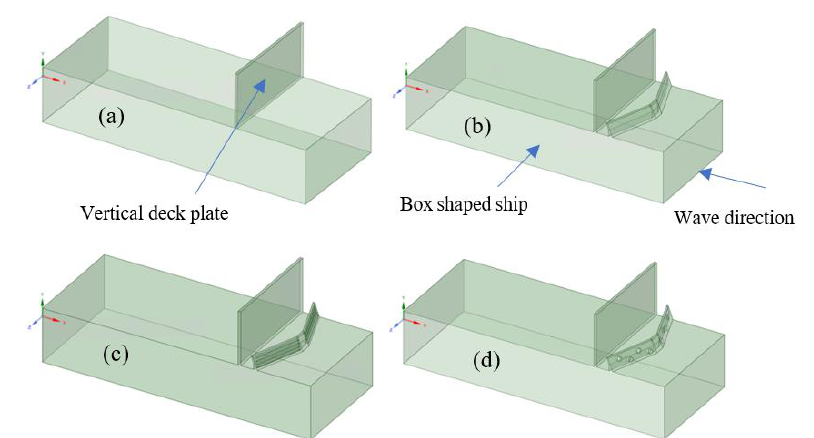
Figure 8. Box ship model developed for this study: ( a ) no breakwaters; ( b ) windshield breakwater; ( c ) horizontal grillage breakwater; ( d ) perforated breakwater.